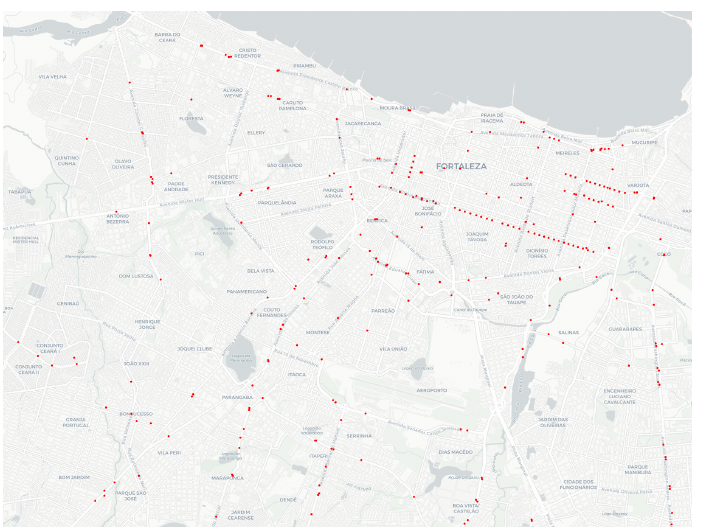
Figure 1. Map of Fortaleza city with external sensors (surveillance cameras) positioned on the road network in 2019.